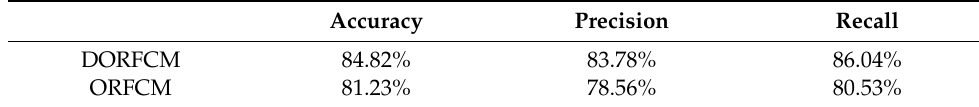
Table 3. Double layered learning effect comparison (88